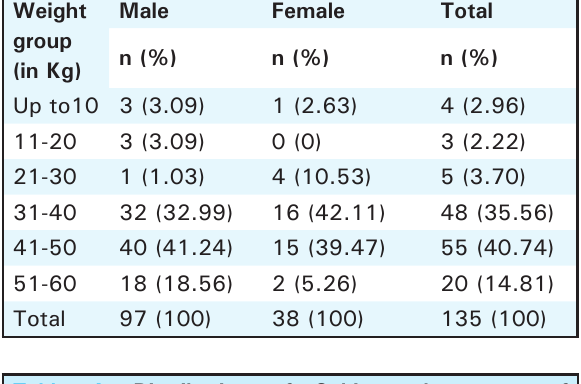
Table 4. Distribution of Subjects by types of Tuberculosis